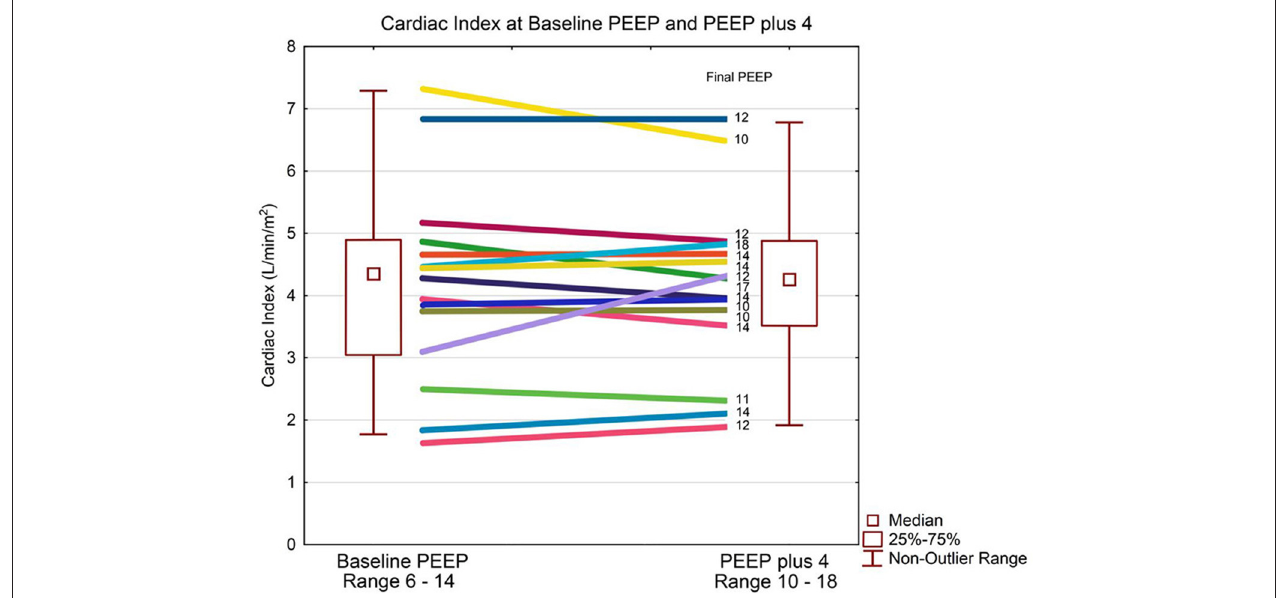
FIGURE 1 | Cardiac index and PEEP. Data are presented as median, inter-quartile, and non-outlier range. The box plot represents the entire group and each patient’s change in cardiac output is displayed as a line diagram with the change from baseline PEEP to PEEP plus 4 cmH 2 O. There is no statistically significant change in